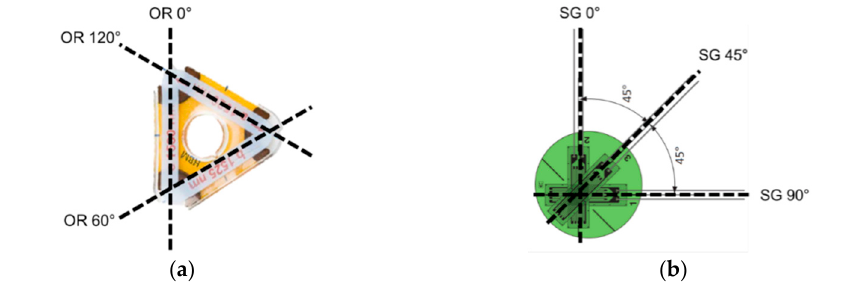
Figure 9. Side view of 3-axis sensor deployment: ( a ) OR sensor; ( b ) SG sensor. For each of the two samples, a total of eight tests were carried out, including three before FRP-forming and one after. The initial load was set to 15 kN for the close contact of the MTS plate and the sample, and the strain was measured by increasing the load up to 588 kN. The FBG strain was measured using an FAZT I4Z (Femto sensing, Atlanta, GA, USA) interrogator, and the SG strain was measured using a dynamic strain amplifier (DPM-711B, KYOWA, Tokyo, Japan).